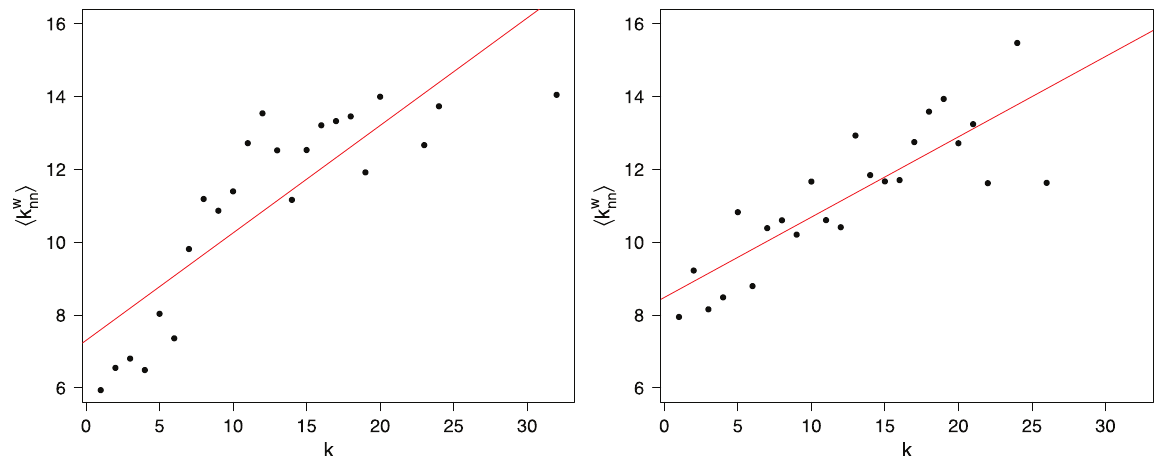
Figure 3. Assortative mixing in the boards projection in 2005 (Left) and 2010 (Right). The plots show the behavior of the weighted average degree of a node’s nearest neighbors as a function of the node degree. Thin red lines display linear regressions: slope coefficients are